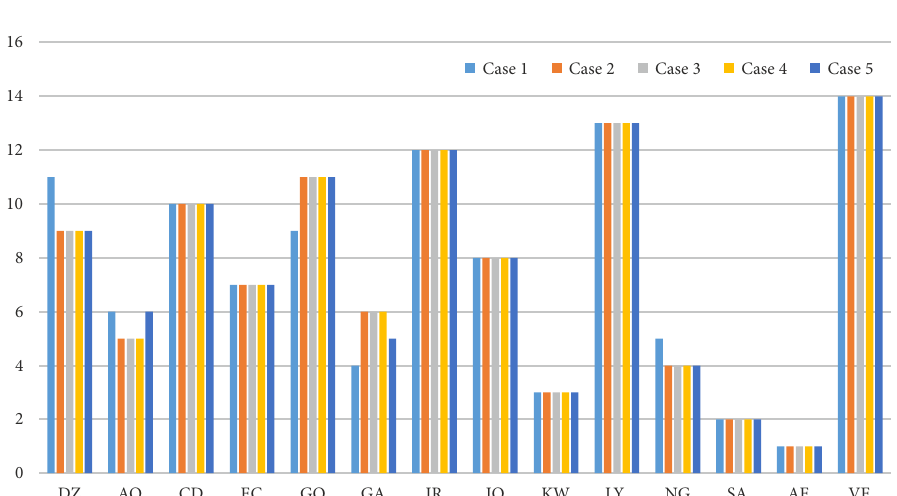
Figure 3. Ranking of alternatives under defined weight